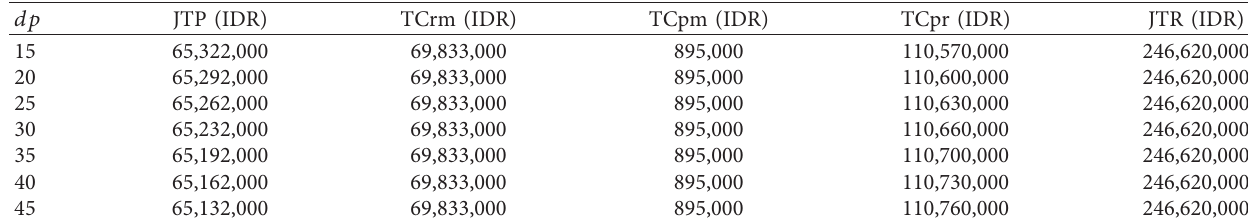
Table 10: Sensitivity analysis of dp effect on cost, revenue, and profit.